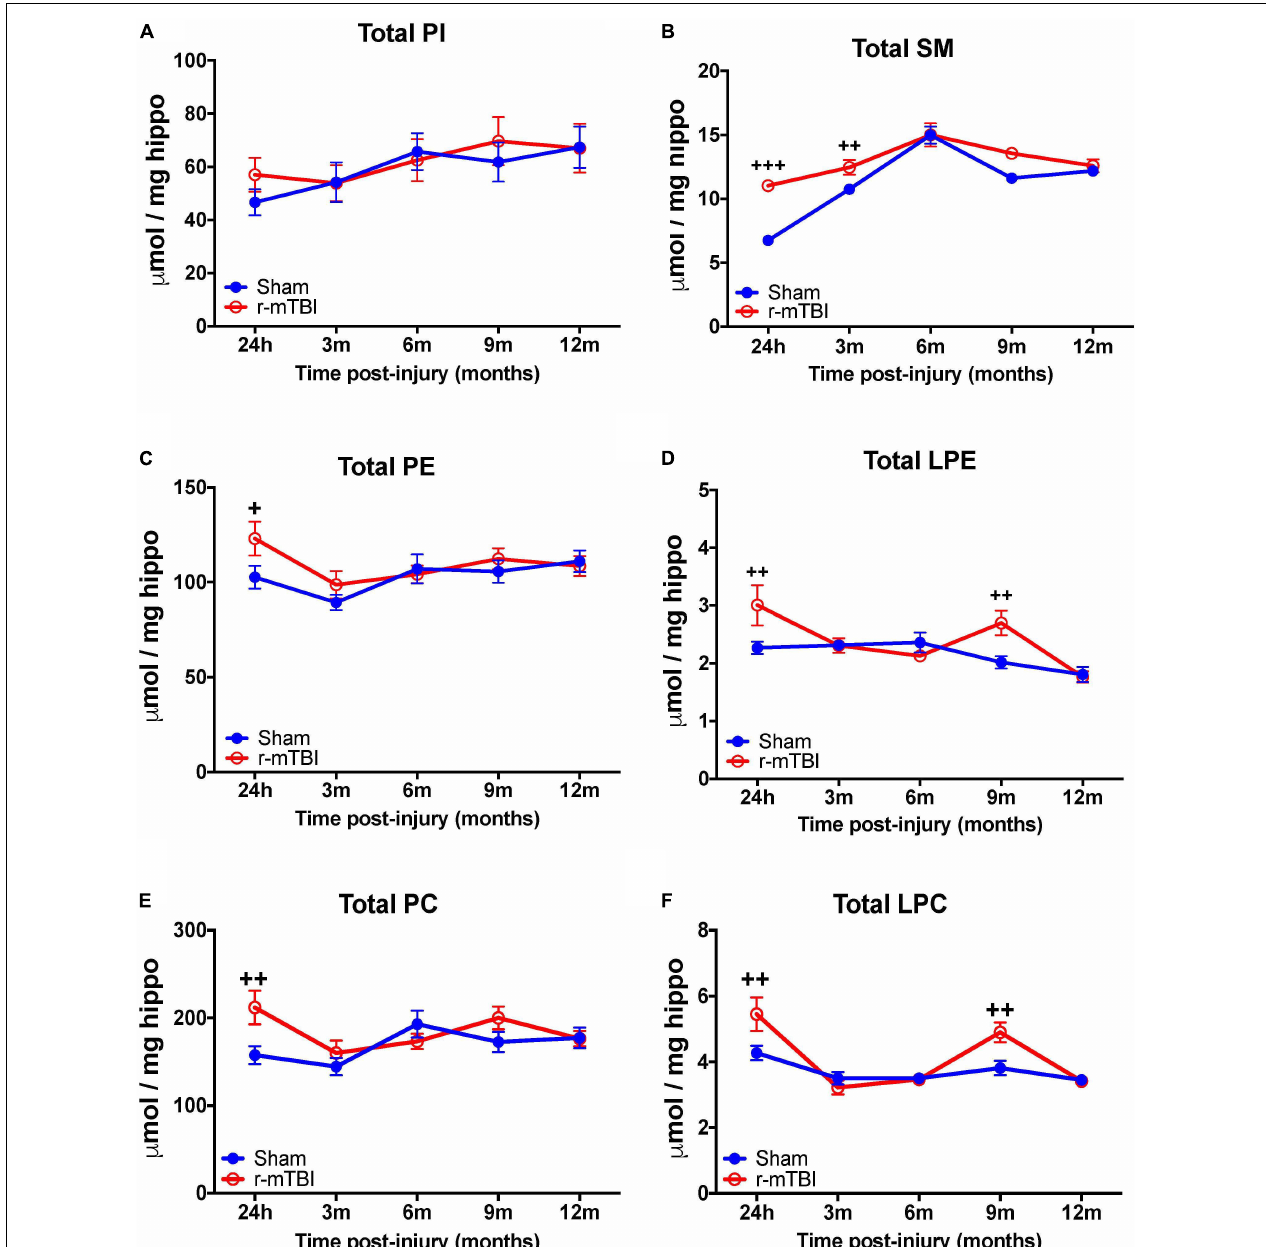
FIGURE 2 | Total Phospholipid levels in the hippocampus of r-mTBI hTau mice. Significant changes in total phospholipid [PI (A) , SM (B) , PE (C) , LPE (D) , PC (E) , LPC (F) ] species in the hippocampus of a model of repetitive-mTBI in hTau mice. Sample size for all groups across all time points is n = 4. All data represent mean µ M per (5.5 mg) wet weight ± SEM. Individual molecular lipid species were quantified by liquid chromatography/mass spectrometry and were summed after LipidomeDB analyses to generate total phospholipid levels. Asterisks represent + P < 0.05, ++ P < 0.01, +++ P < 0.001 for comparisons between sham/r-mTBI mice. PE, phosphatidylethanolamine; LPE, lysophosphatidylethanolamine; PC, phosphatidylcholine; LPC, lysophosphatidylcholine; PI, phosphatidylinositol; SM,